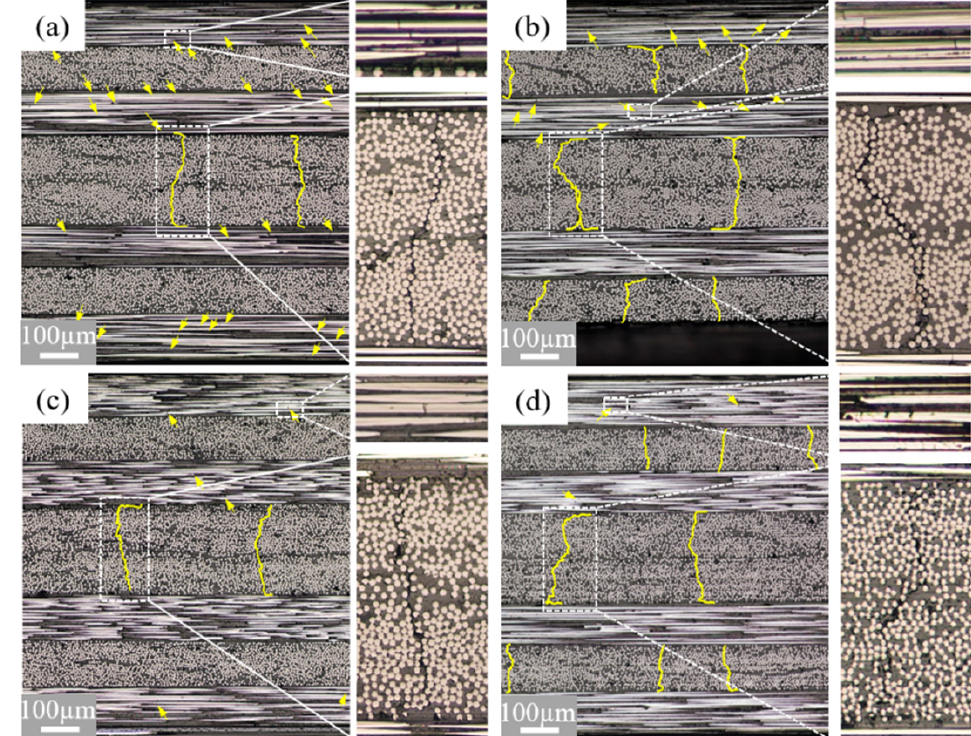
Figure 8. Damage images of the [0/75] 2s and [0/90] 2s laminates: ( a ) [0/75] 2s at the free edge; ( b ) [0/90] 2s at the free edge; ( c ) [0/75] 2s in the central section; ( d ) [0/90] 2s in the central section.